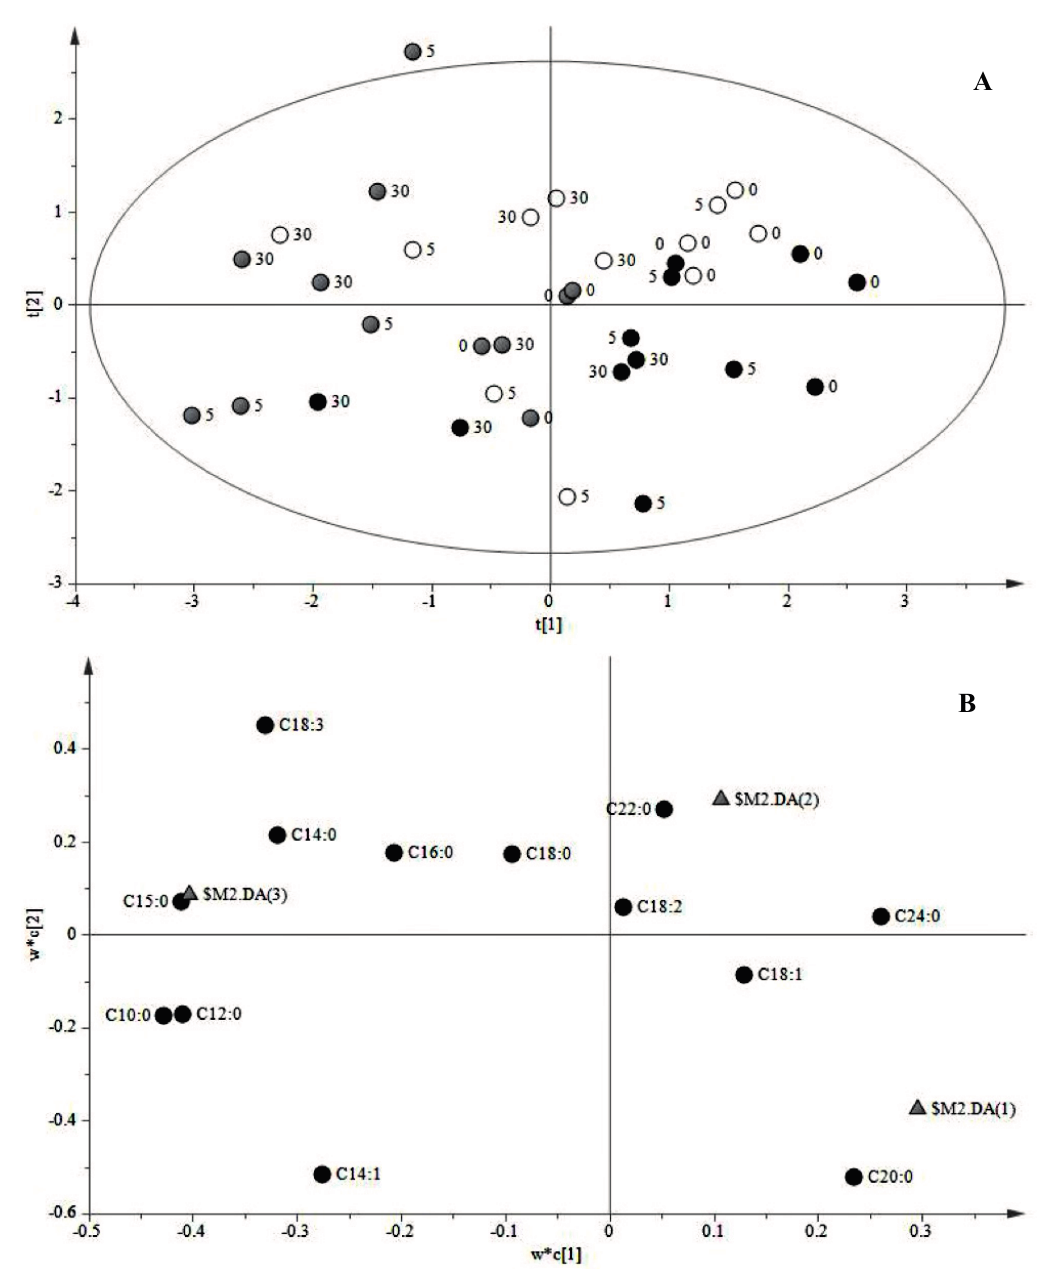
Figure 2. PLS-DA of cell suspension cultures of C. roseus treated with JA. ( A ) Scores plot of FA forming the first class (0–5–30 min after induction). ( B ) Loadings plot of the first class (0–5–30 min after induction. ( C ) Scores plot of FA forming the second class (90–360–1440 min after induction). ( D ) Loadings plot of the second class (90–360–1440 min after induction). Black circles: JA-treated cells; white circles: untreated cells; grey circles: mock (40%